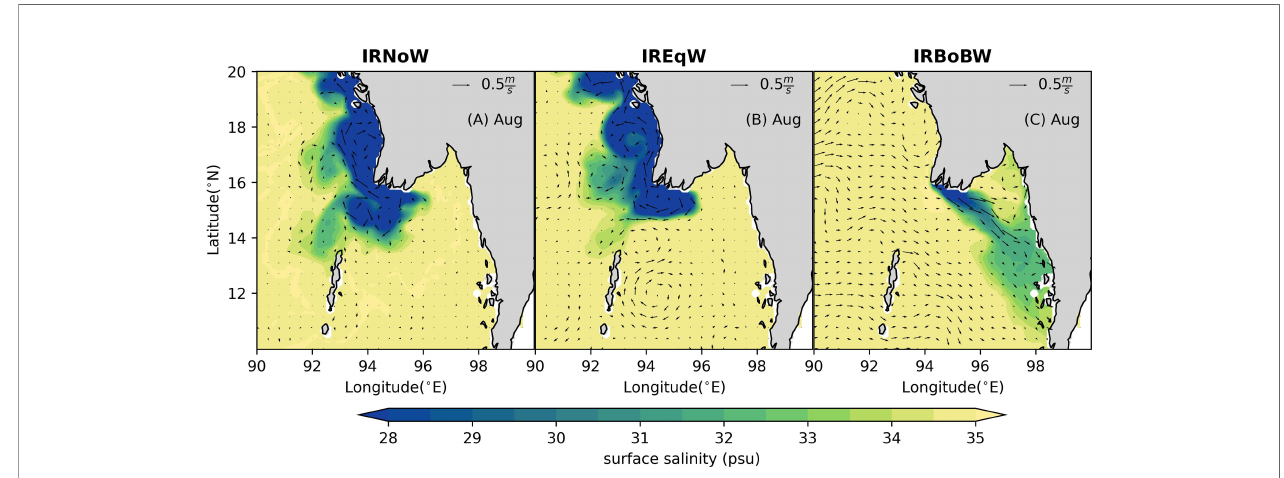
FIGURE 11 | Maps of monthly averaged sea surface salinity(psu) and surface currents(ms -1 ) for the month of August from the fi rst year of experiment IRNoW (left), IREqW (center) and IRBoBW